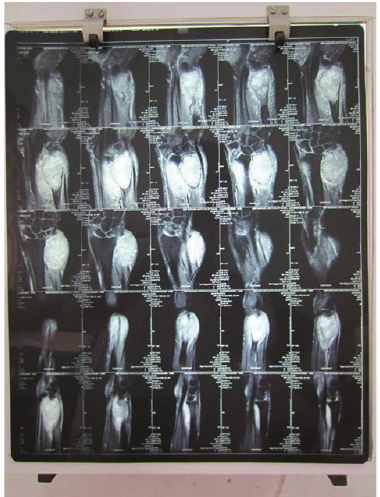
Figure 5: Preoperative MRI.